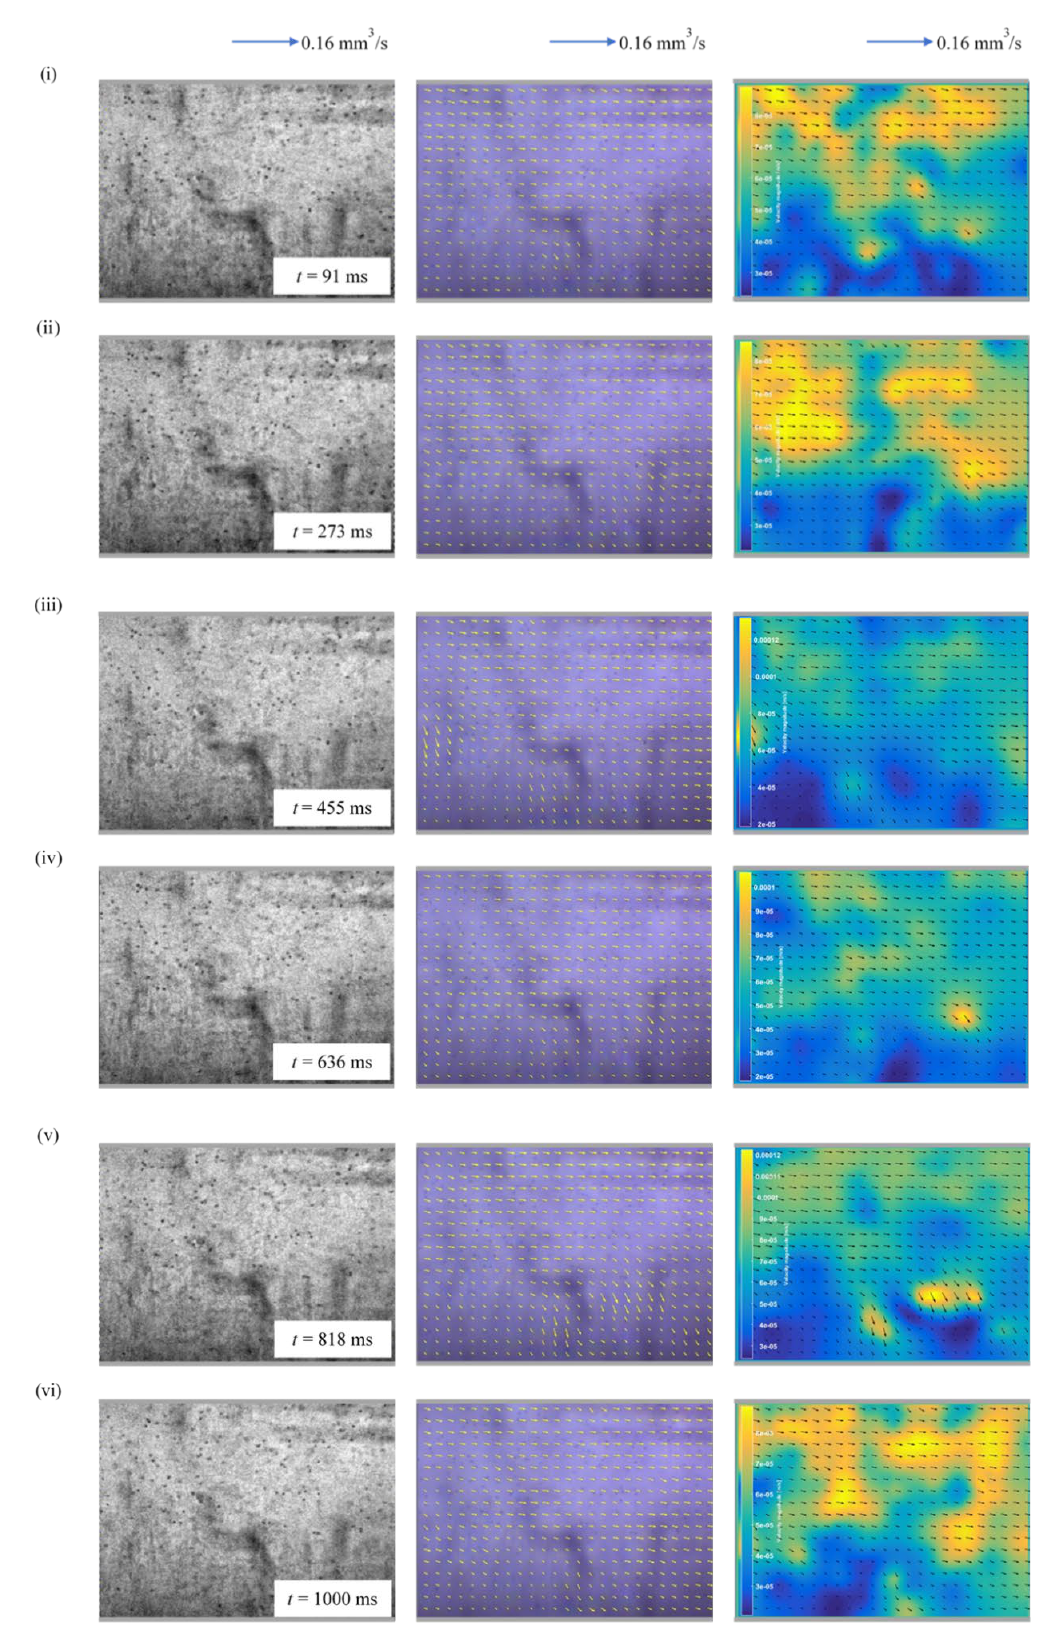
Figure 8. Pre-processing image, vector and velocity magnitude for the offset T-junction microchannel with a radius of 1000 µm at ( i ) 91 ms, ( ii ) 273 ms, ( iii ) 455 ms, ( iv ) 636 ms, ( v ) 818 ms and ( vi ) 1000 ms.